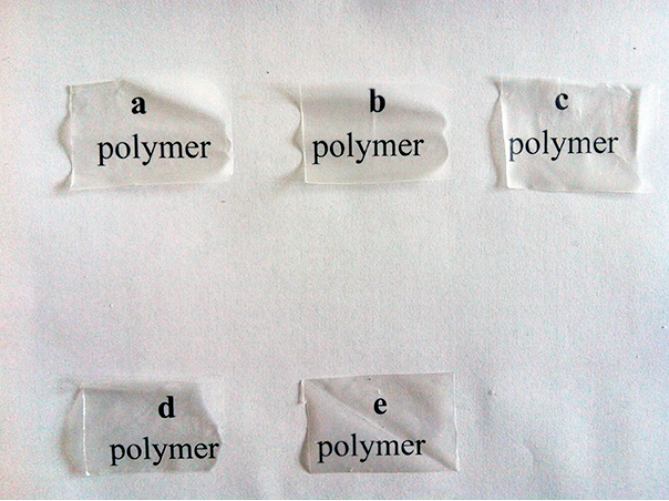
Table 2. The visual properties of PLA/PTMC/OEO composite films.